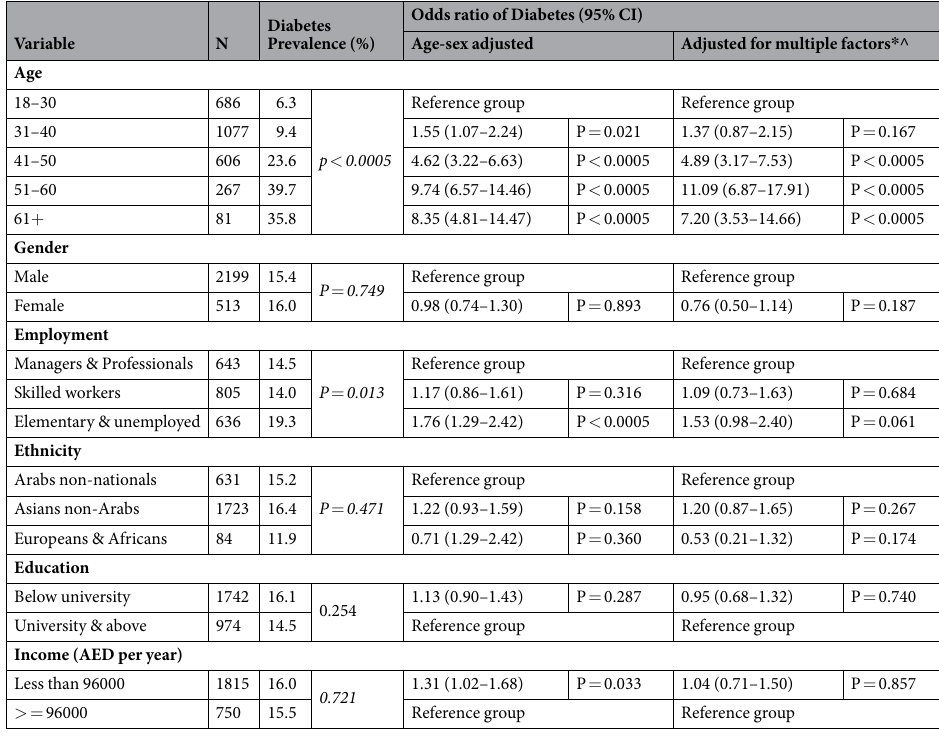
Table 2. Prevalence and Risk of Diabetes by Demographic Factors. * Adjustment was made for age, gender, employment, ethnicity, education and income. ^Omnibus test model ( χ 2 = 187.512, p < 0.0005); Cox & Snell R 2 = 0.100 & Nagelkerke R 2 = 0.169; Hosmer & Lemeshow Test ( χ 2 = 1.250, df = 8, p =